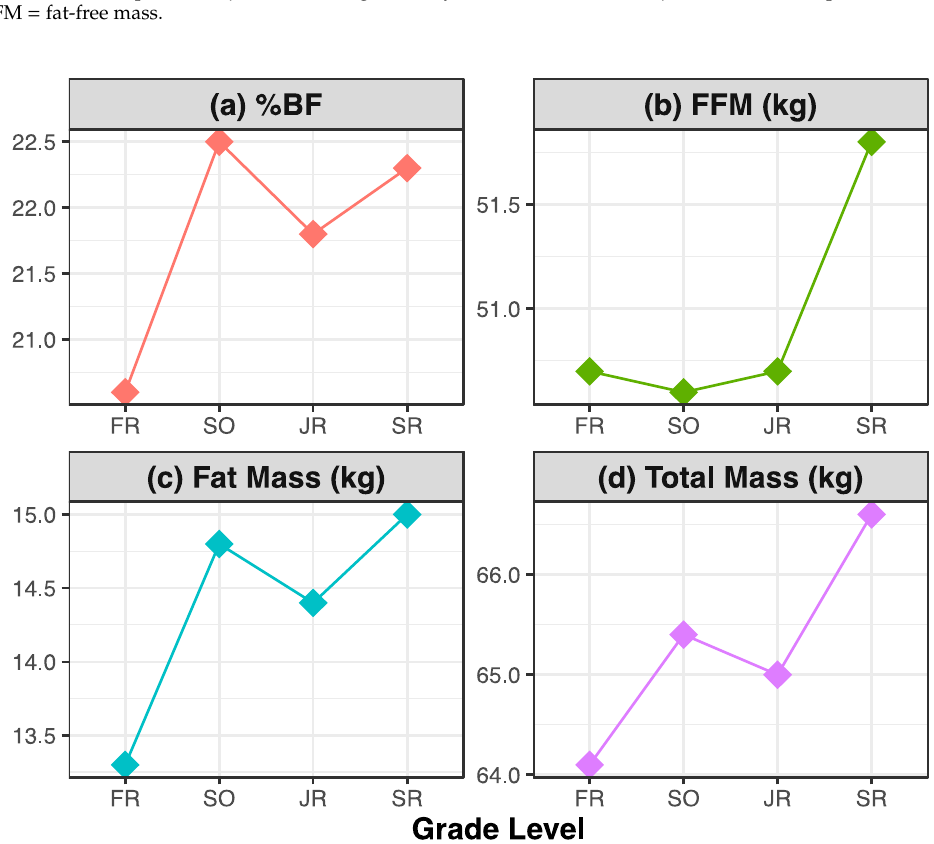
* Observed mean ± SE (Adjusted mean ± SE). ^ Significantly different than Freshman, p < 0.05. § Significantly different than Sophomore, p < 0.05. † Significantly different than Junior, p < 0.05. %BF =